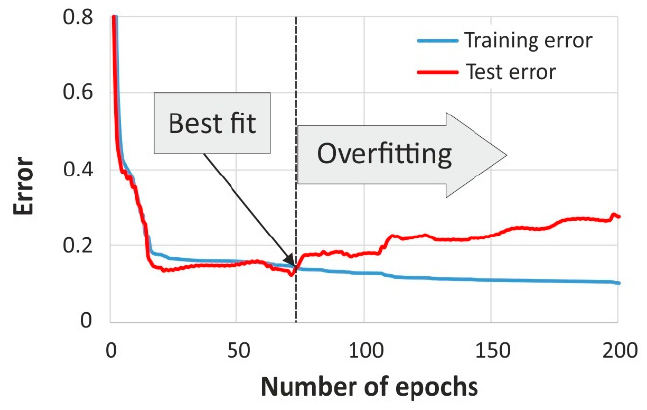
Figure 5. Error value changes in a typical artificial neural network training process.